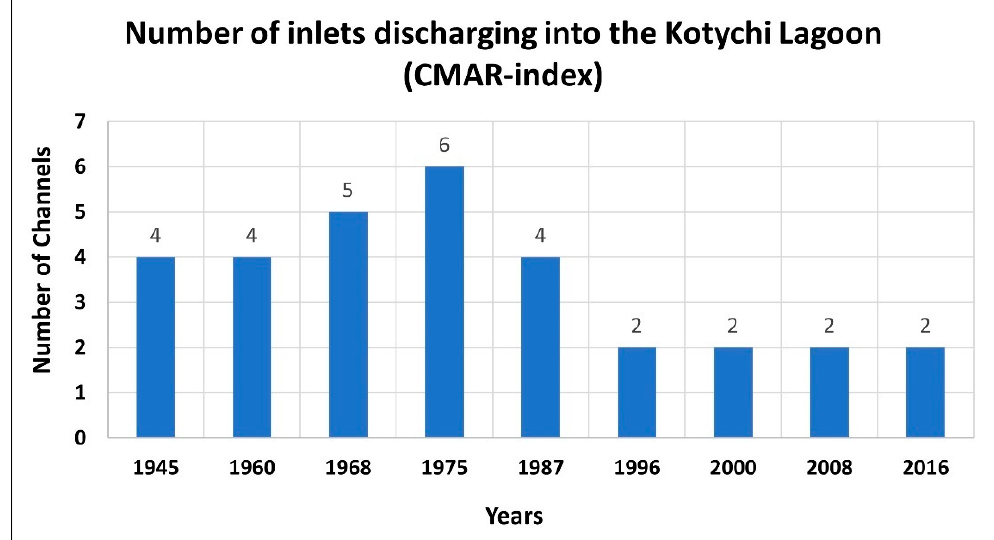
Figure 7. Number of inlets (CMAR-index) diachronically discharging their water into the Kotychi Lagoon.